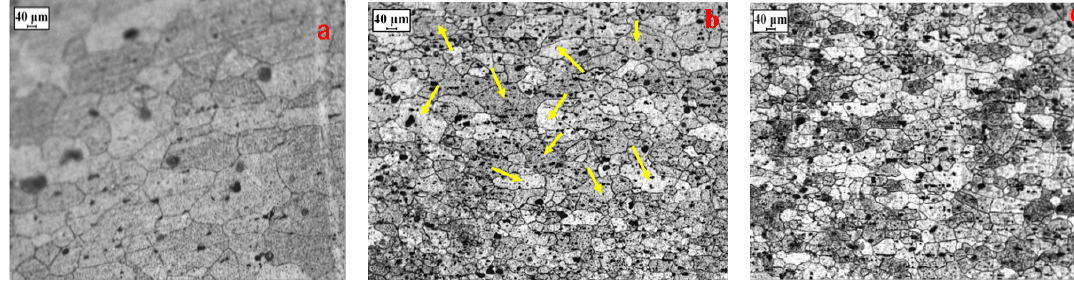
Figure 11. Microstructure of samples after aging: ( a ) matrix; ( b ) LP ‐ treated (1.8 J + 25 °C); ( c ) WLP ‐ treated (1.8 J + 120 °C).